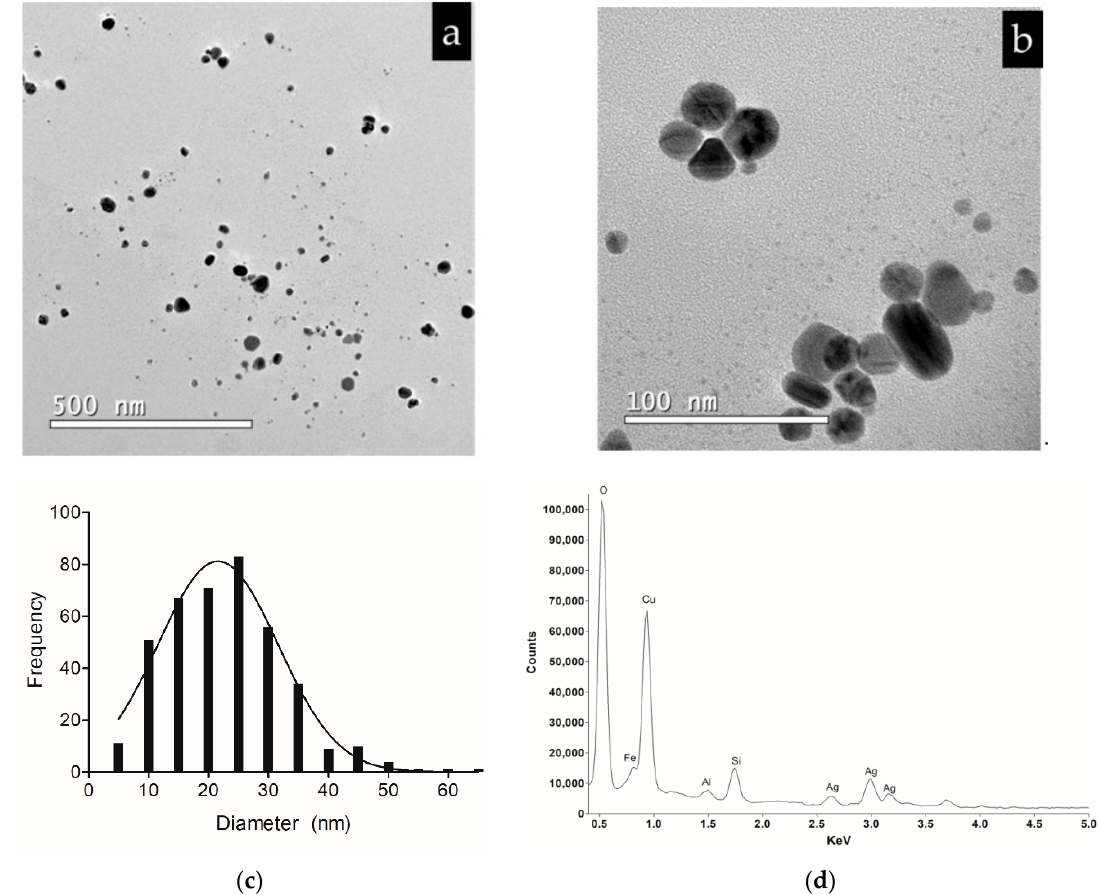
Figure 2. Micrographs of biosynthesized AgNPs obtained by TEM. ( a ) Distribution of AgNPs on a scale of 500 nm; ( b ) AgNPs on a scale of 100 nm with morphology mostly spherical. ( c ) Histogram of the size distribution of AgNPs according to micrographs obtained by TEM (n = 403). ( d ) Energy dispersive X-ray (EDX) spectrum of AgNPs.